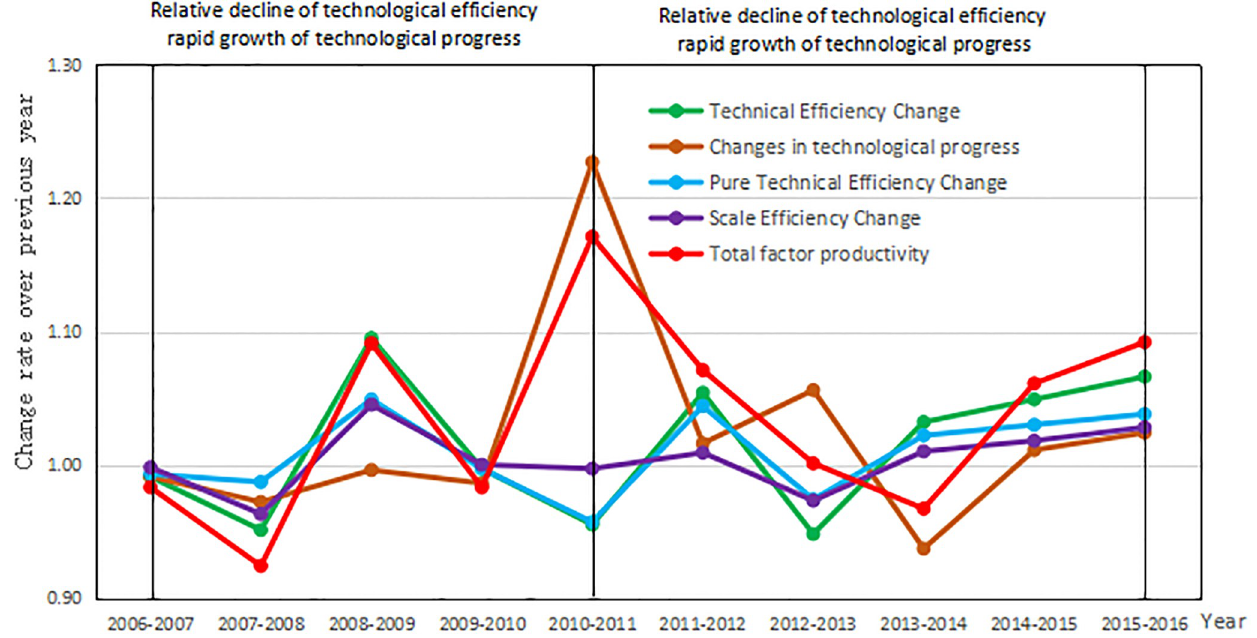
Fig 5. Time series evolution of the efficiency of technological innovation of China’s high-tech industry from 2006 to 2016. https://doi.org/10.1371/journal.pone.0231335.g005 total factor productivity in the 30 provinces (municipalities, autonomous regions) and 22 rises (Table 3) in 2006–2016. The total factor productivity of economically backward areas, such as the northwestern and northern areas, and regions of Yunnan, economically developed areas such as Jiangsu, Zhejiang, Shanghai, and the southern coastal areas declined significantly. The total factor productivity of the middle and upper reaches of the Yangtze River, the Yellow River Basin, and the three northeastern provinces showed a clear upward trend, with the Table 3. Classification of total factor productivity and its decomposition index for China’s high-tech industry in 2006–2016.